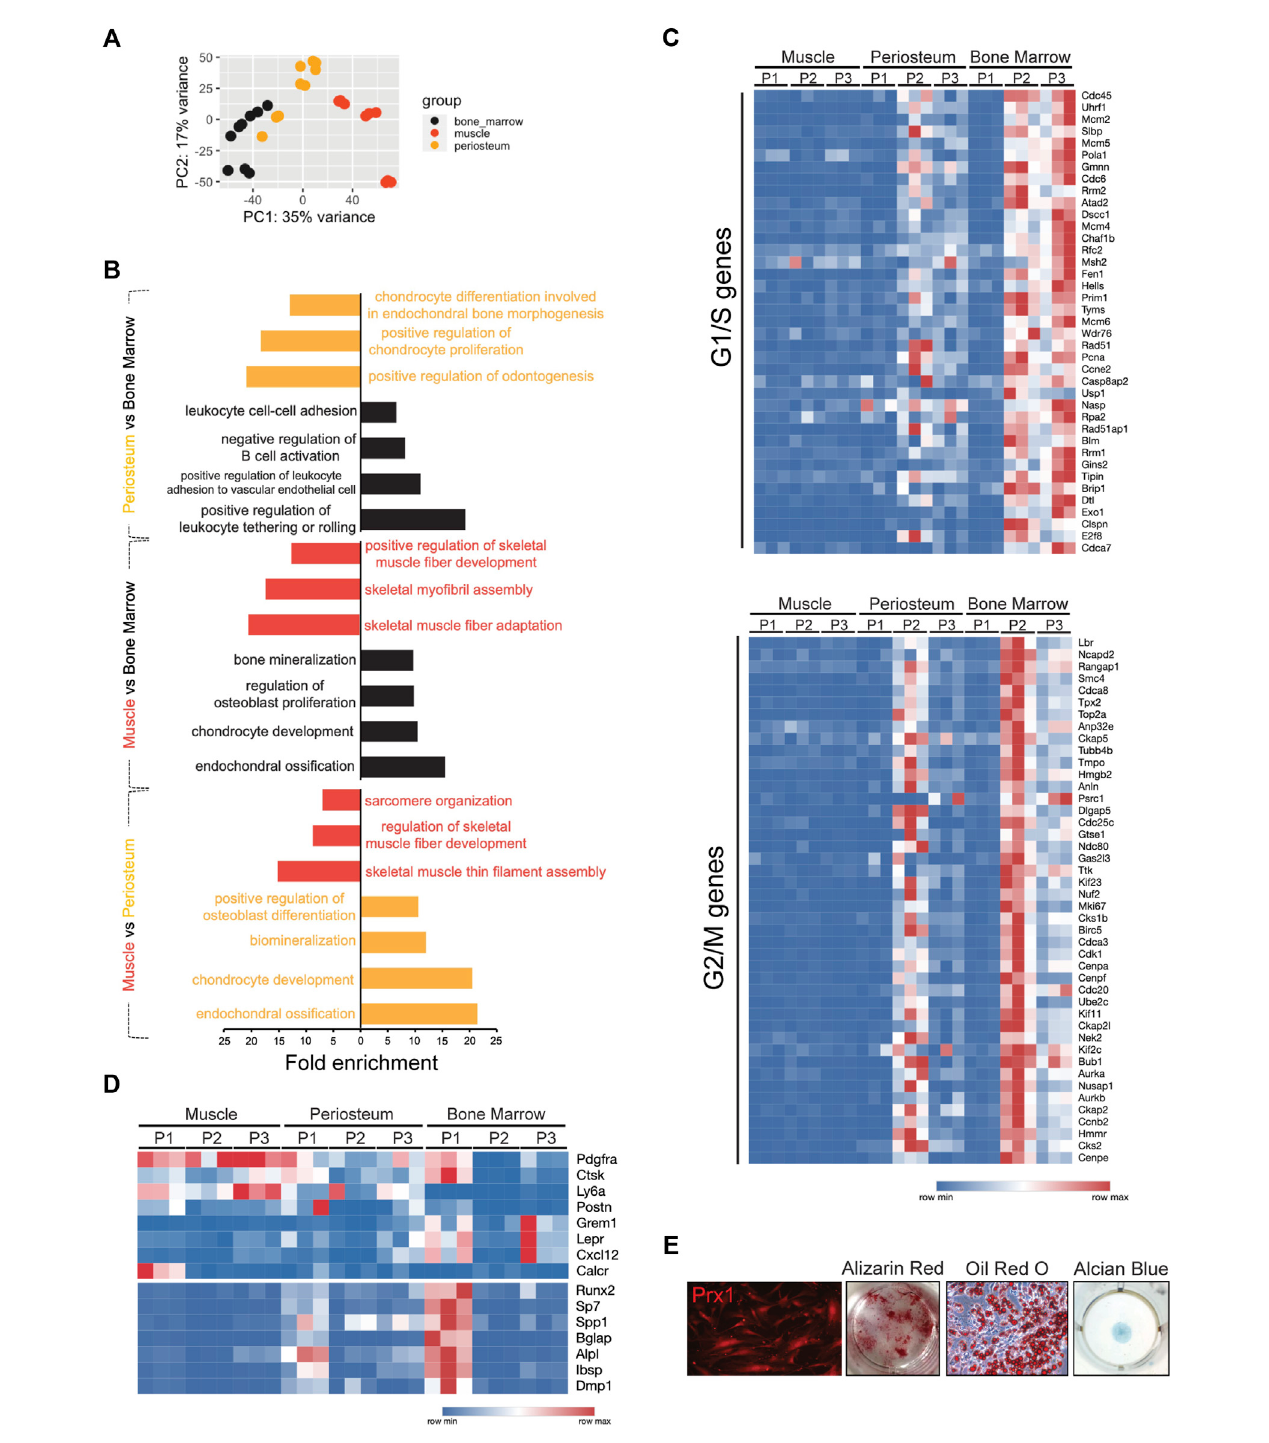
FIGURE 5 Bulk RNA-seq analysis of Prx1-derived cells from bone marrow, periosteum, and muscle. (A) . Principal component analysis of RNA-seq following FACS of Prx1- derivedthreesubpopulationsfrombonemarrow,periosteumandmuscletissues. n =3micepergroup. (B) .GOanalysesofPrx1cellsfromthreetissues:periosteumvs. bone marrow, muscle vs. bone marrow, muscle vs. periosteum, respectively. (C) . Heatmap of expression of the cell cycle-related genes in Prx1 subpopulations from bone marrow, periosteum and muscle. (D) . Heat map of gene expression in Prx1 subpopulations from bone marrow, periosteum and muscle. (E) . Images of cultured muscle-resident Prx1-derived P1 cells. Left to right: images of cells at Day21 post-harvest; Alizarin red, oil red O and alcian blue staining of cells. N = 5